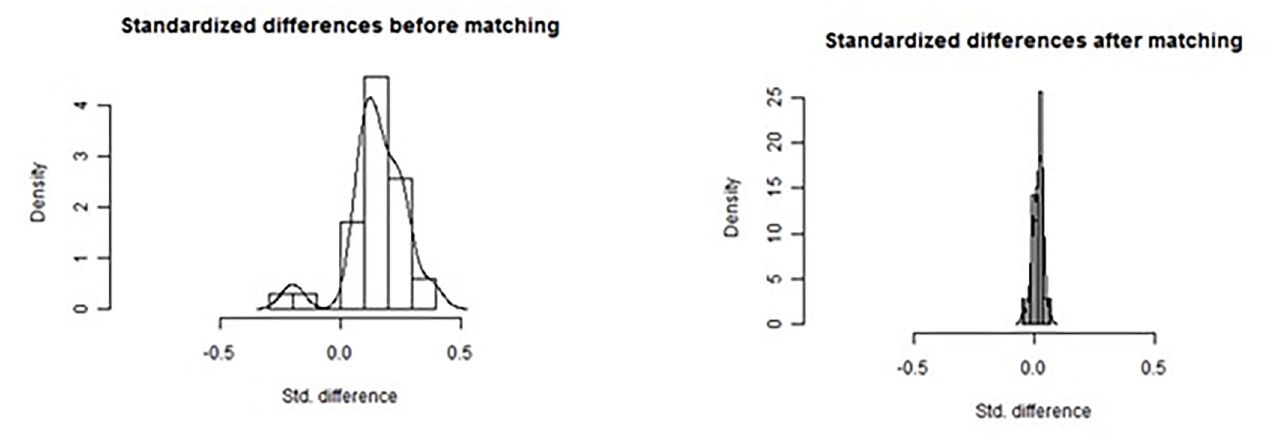
Fig 2. Cohort distribution before and after propensity score